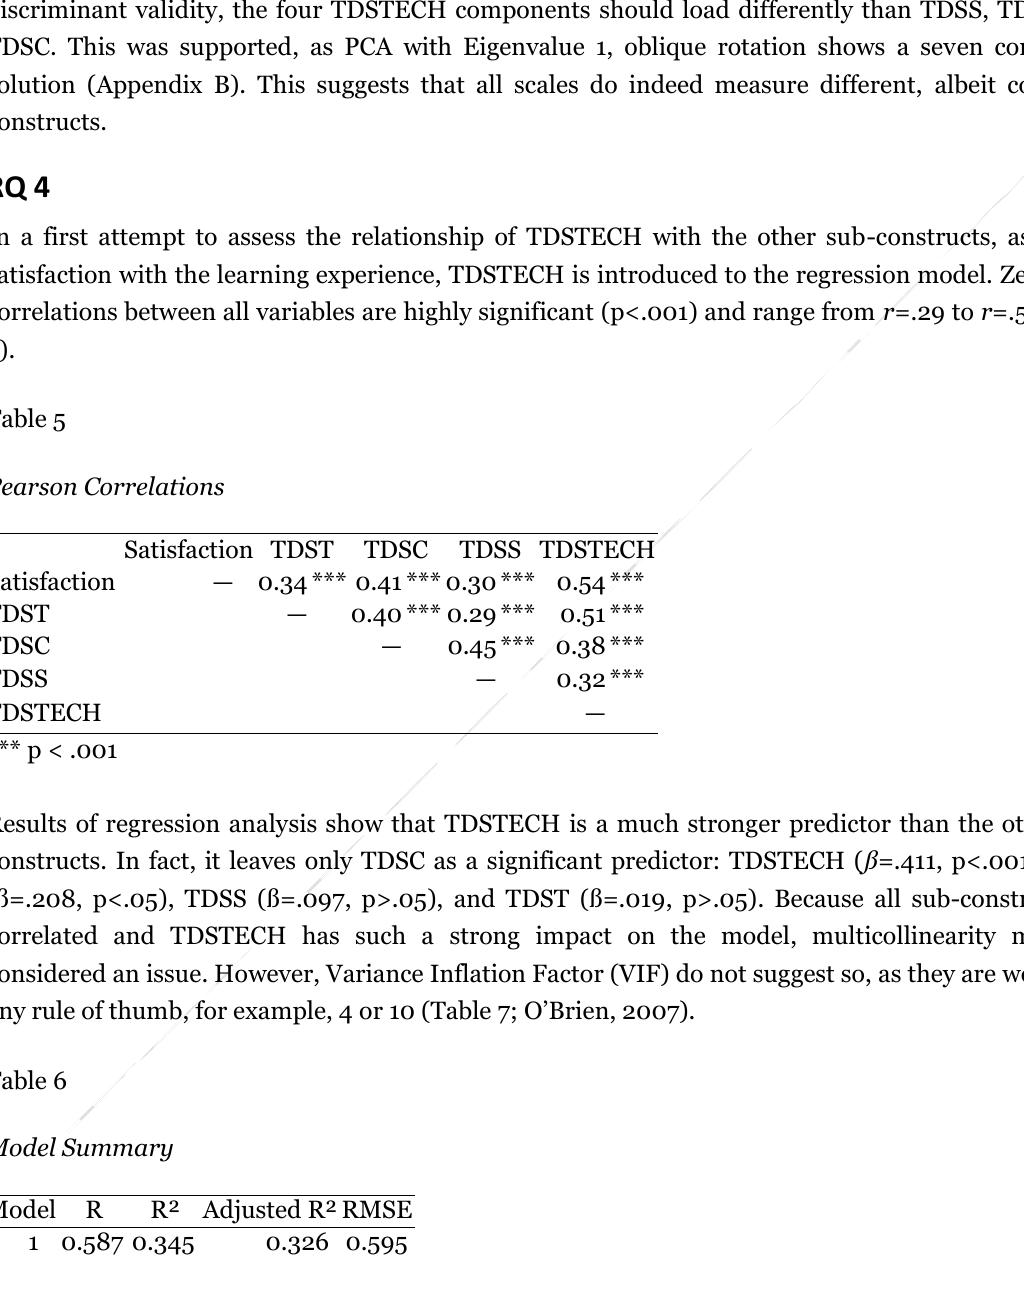
Model Summary Model